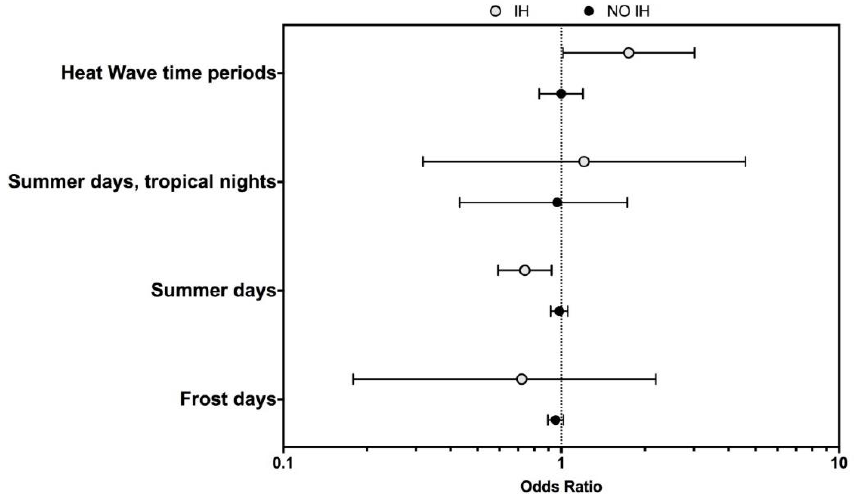
Figure 2. Occupational injuries (OIs) among the EMRO workers stratified by meteorological characteristics of the calendar day of occurrence in the Autonomous Province of Trento (APT) between 2000 and 2013 broken down by Islamic Holiday time-period (IH) vs. not IH.